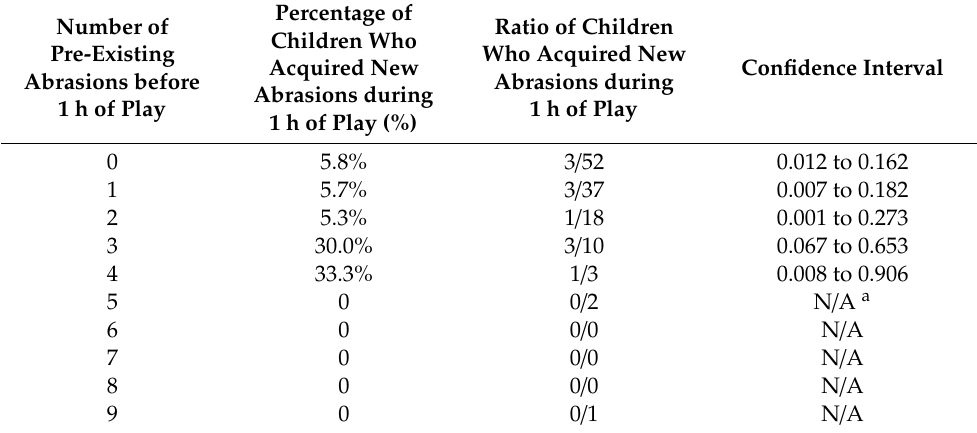
Table A1. Number of pre-existing abrasions per child with a comparison of the probability of acquiring a new abrasion during one hour of